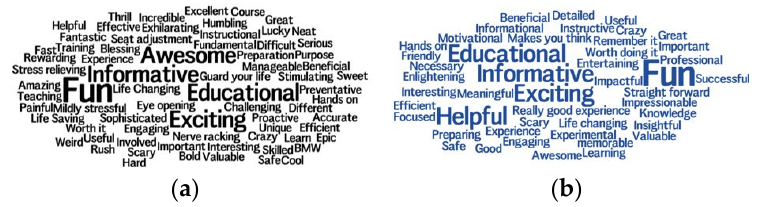
Figure 6. Word cloud of key words: survey ( a ) and interview ( b ).